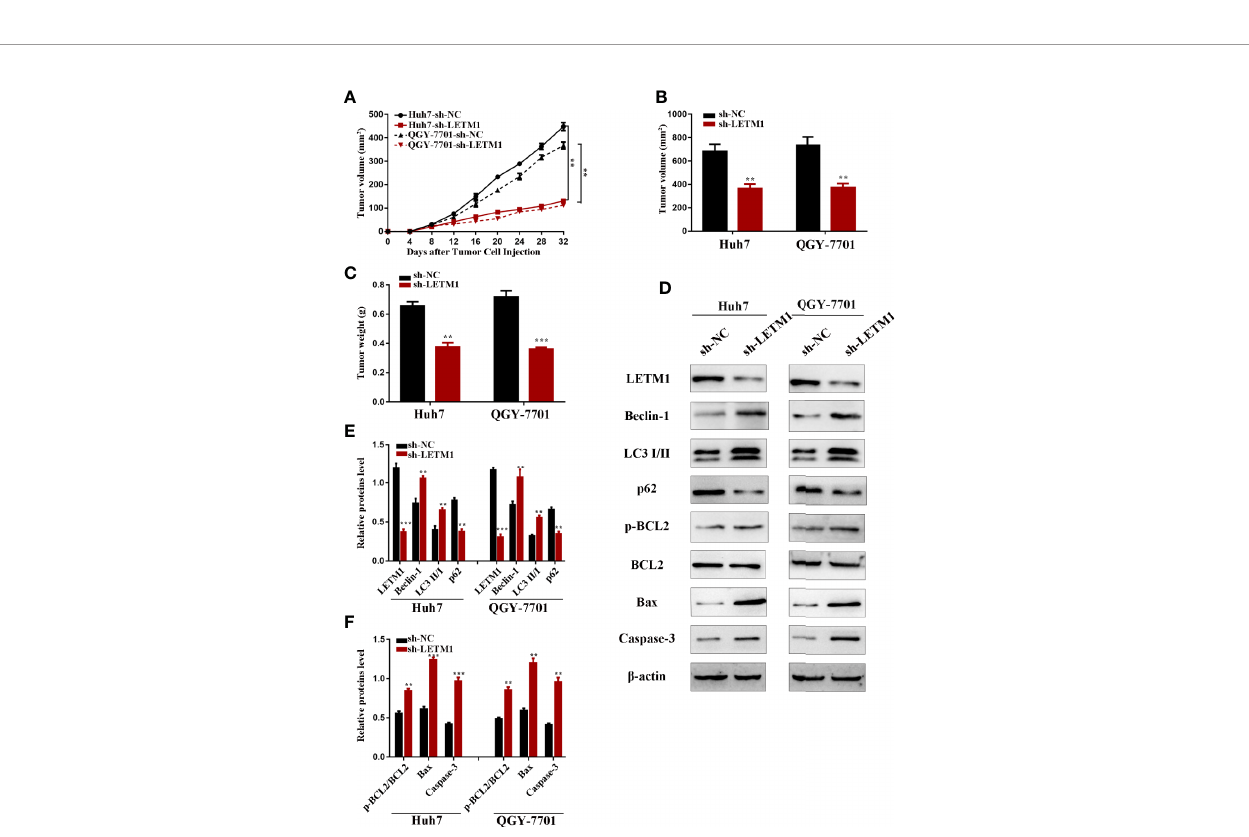
FIGURE 5 | LETM1 knockdown promotes autophagy and apoptosis through AMPK mediated Beclin-1/Bcl-2 complex dissociating in hepatocellular carcinoma cell. (A) Co-immunoprecipitation experiment of the interation of Beclin-1 and Bcl-2 in in LETM1-knockdown along with AMPK inhibitor Huh7 cell line. (B) Co-immunoprecipitation experiment of the combination of Beclin-1 and Bcl-2 in in LETM1-knockdown along with AMPK inhibitor QGY-7701 cell line.